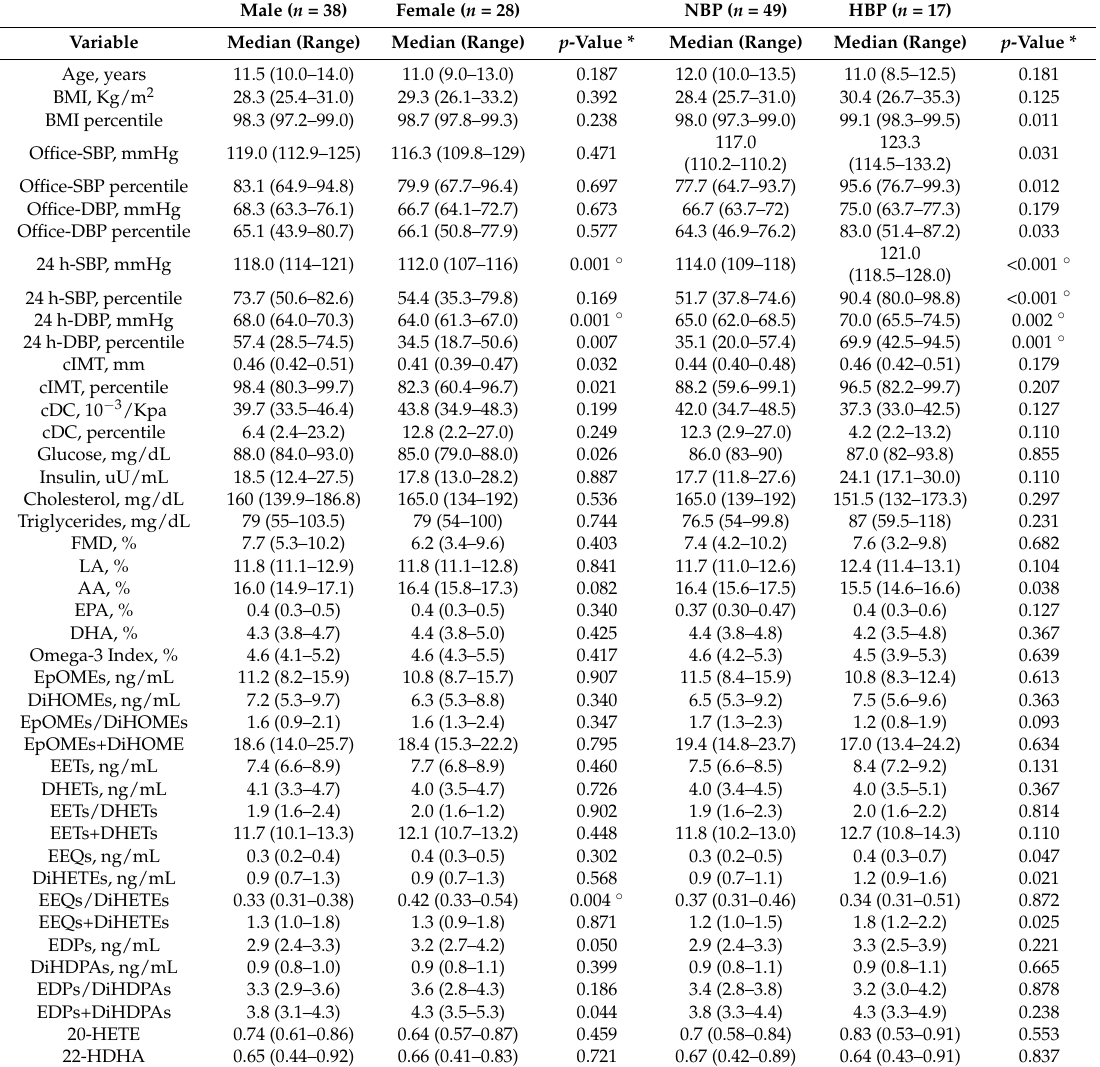
Table 1. General characteristics of the population divided according to gender and blood pressure